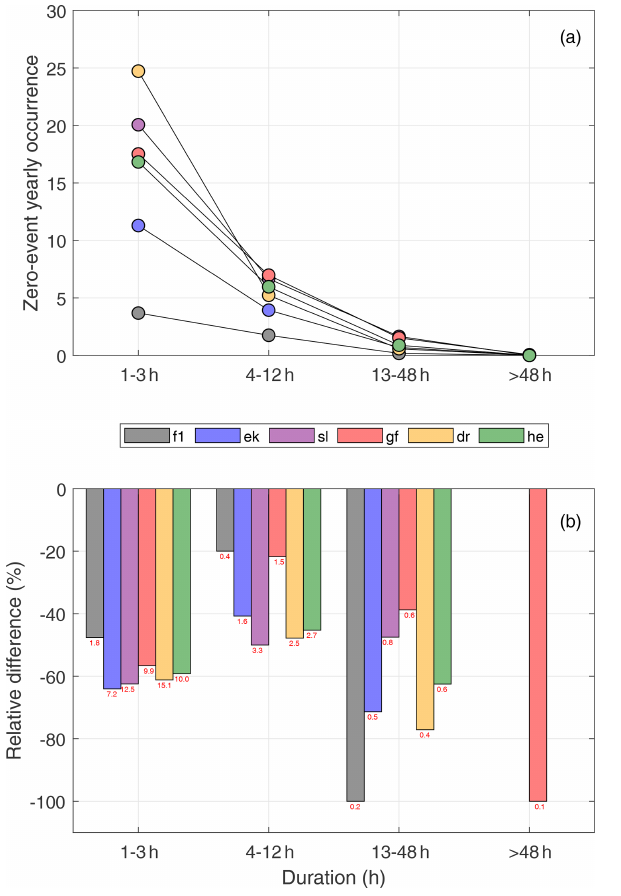
Figure 9. (a) Yearly occurrence and corresponding duration of observation-based zero events caused by wind speeds lower than cut-in wind speed ( u < u ci ). (b) The differences between model- based (n3) and observation-based (obs) zero-event occurrences di- vided by the total number of observed occurrences of too low wind speeds. Values over or under each bar correspond to the differ- ences (n3 − obs) in the number of yearly occurrences between the model and observations. Abbreviations: f1: FINO1; ek: Ekofisk; sl: Sleipner; gf: Gullfaks C; dr: Draugen; he: Heidrun.